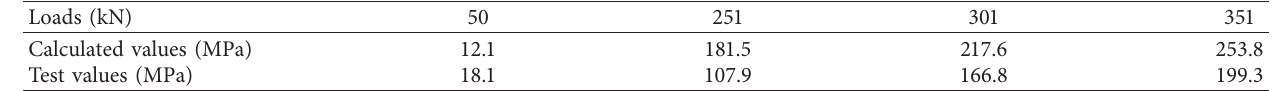
Figure 16: Load-compressive strain on concrete in (a) JP1; (b) JP2; and (c) JP3. Table 4: Tensile stress of rebar at different loads.